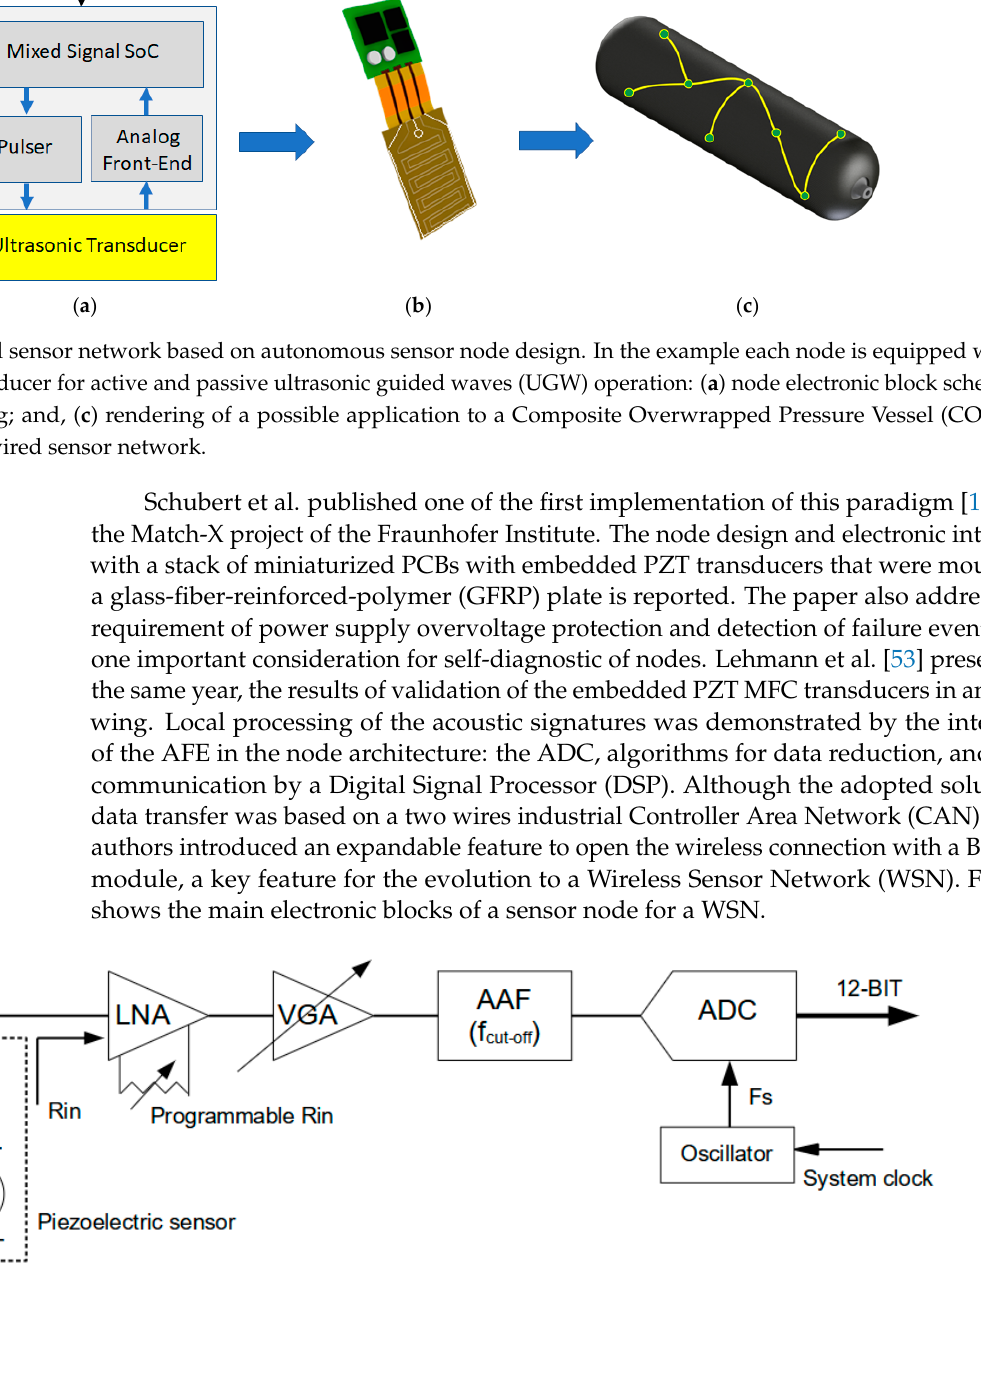
Figure 11. Programmable single channel AFE for signal conditioning of piezoelectric sensor.